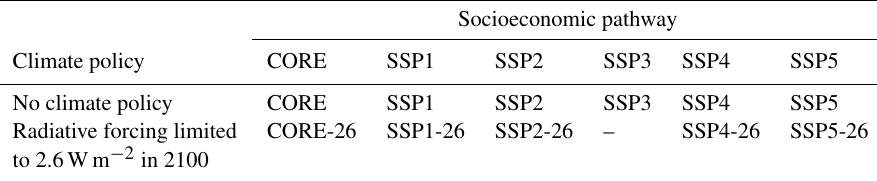
Table 1. Scenarios included in this paper. Scenarios are categorized by their socioeconomic pathway (columns) and their mitigation policy (rows). Cell values are the names of the scenarios used in the rest of the paper. Note that the SSP3-2.6 is infeasible and thus omitted from the table and the rest of the